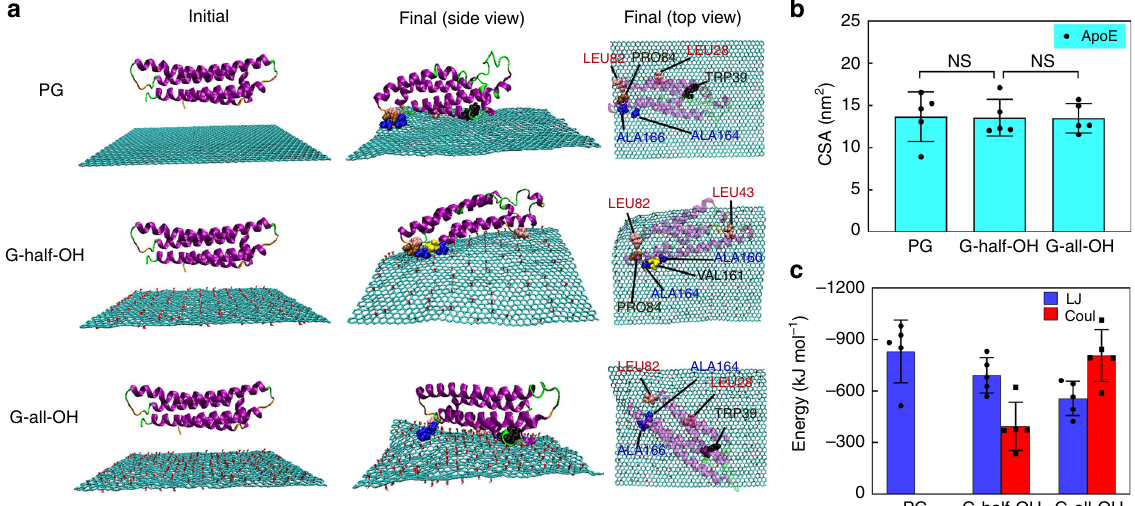
Fig. 4 The simulation results of the interaction of ApoE with the graphene sheet. a Typical snapshots of the initial and fi nal structures of the adsorption of ApoE onto the sheet (cyan) with different surface modi fi cations. From the side and top views, hydrophobic residues within 0.5 nm distance from the sheet surface are represented as CPK spheres. Water molecules and ions are omitted for clarity. b , c The contact surface area (CSA) and the Lennard – Jones (LJ) and Coulomb (Coul) interaction energy between ApoE and the graphene with different surface modi fi cations, respectively. Data are presented as mean ± s.e.m. ( n = 5). p Values were calculated using multiple t tests (NS stands for statistically insigni fi cant difference)